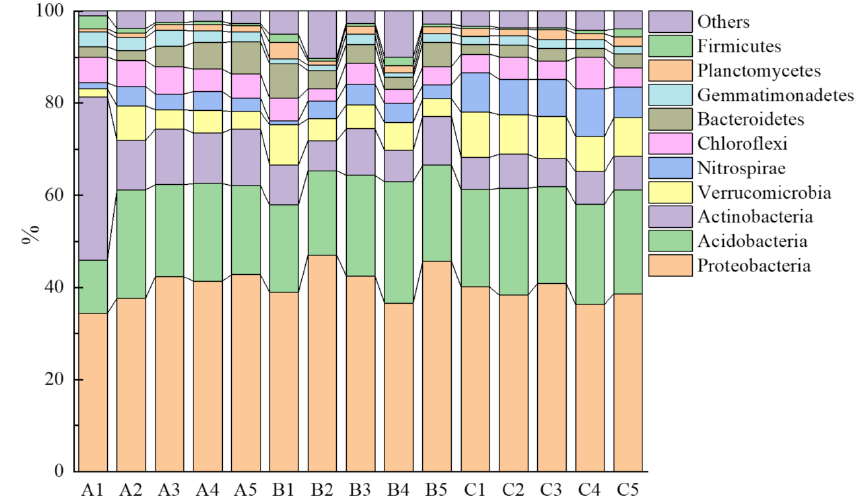
Figure 3. The relative abundances of the dominant bacterial phyla (top